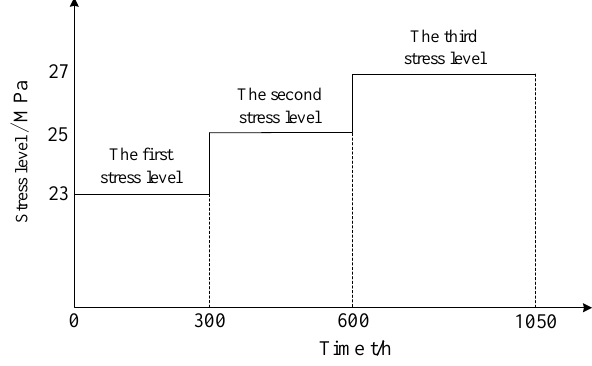
Figure 5. Schematic of step-stress acceleration degradation test.